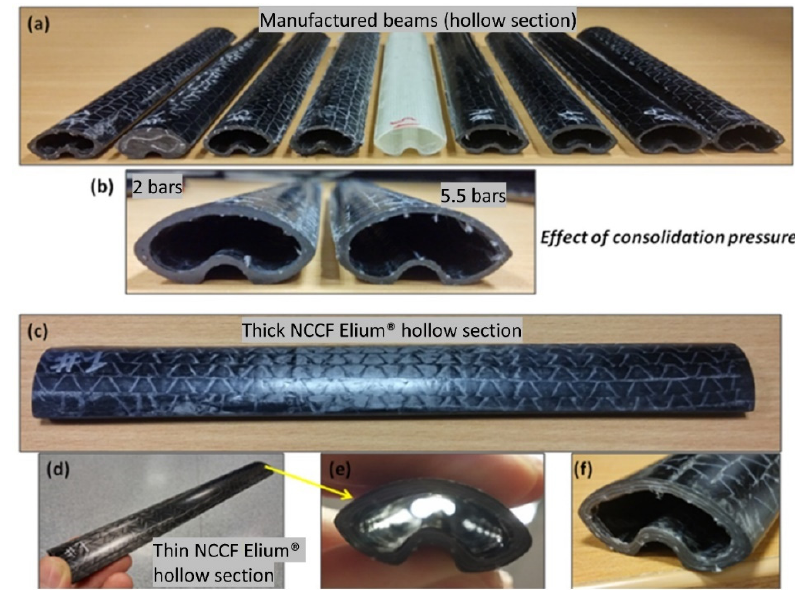
Figure 11. Manufactured Thin and Thick NCCF Elium ® Composite tubular sections (beams) and effect of consolidation pressure ( a ) different beams ( b ) effect of consolidation pressure ( c ) thick NCCF Elium hollow section ( d ) Thin NCCF Elium hollow section ( e – f ) cross section of thin Elium tube.